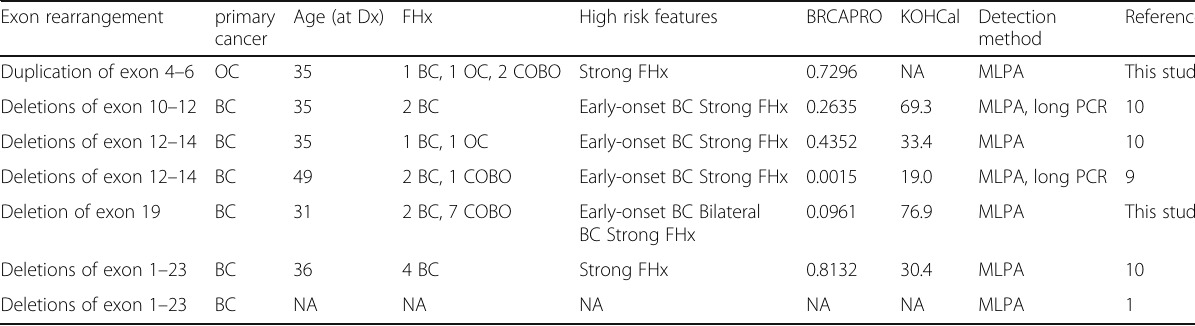
Table 3 Risk characteristics of BRCA1 large genomic rearrangements reported in